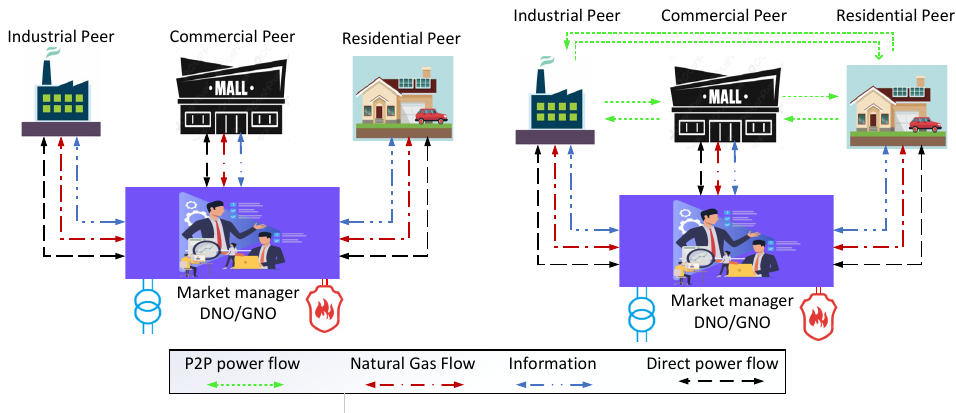
Figure 9. Energy flow in case of energy hub